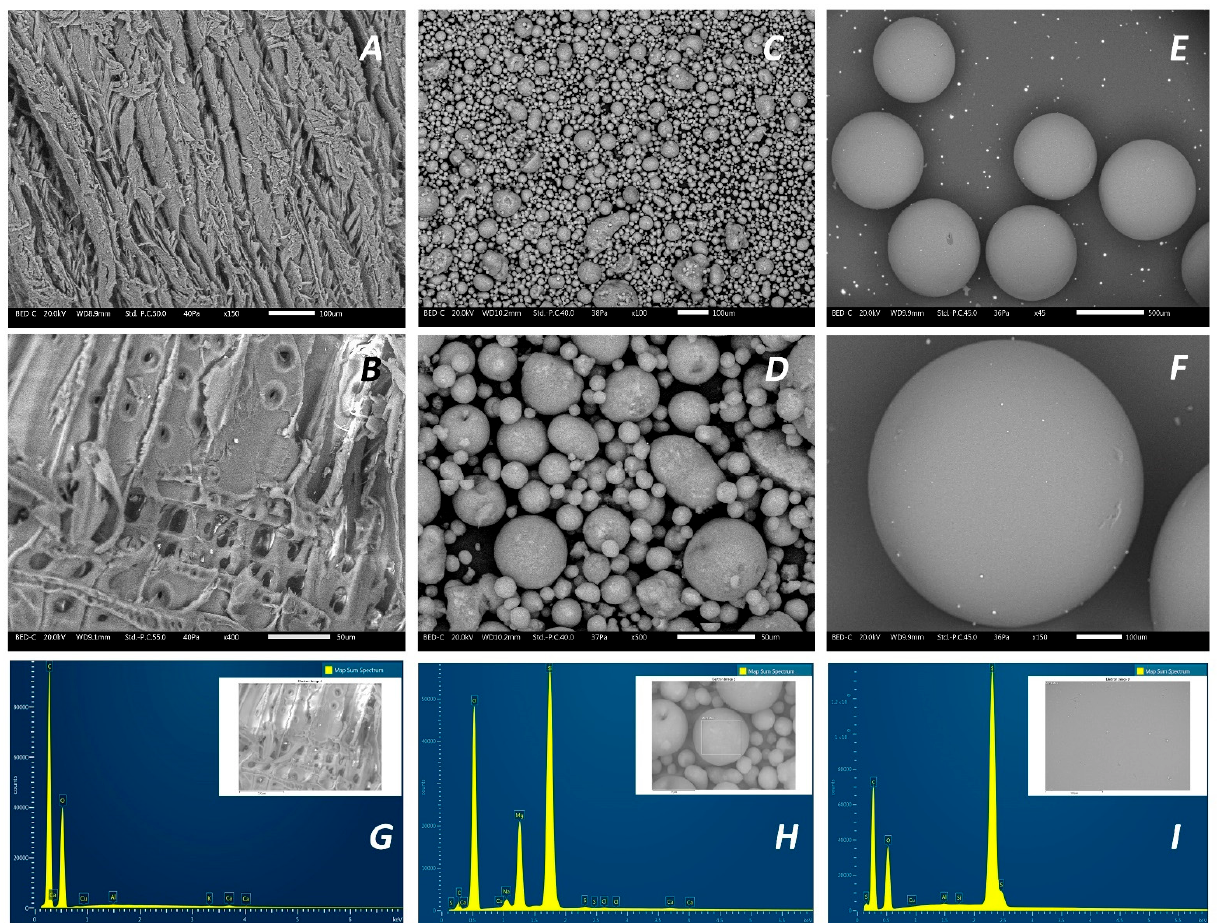
Figure 3. SEM images and EDS analysis for sawdust ( A × 150, B × 400, G ), Magnesol ( C × 100, D × 500, H ), and Amberlite BD10DRY ( E × 45, F × 150, I ).